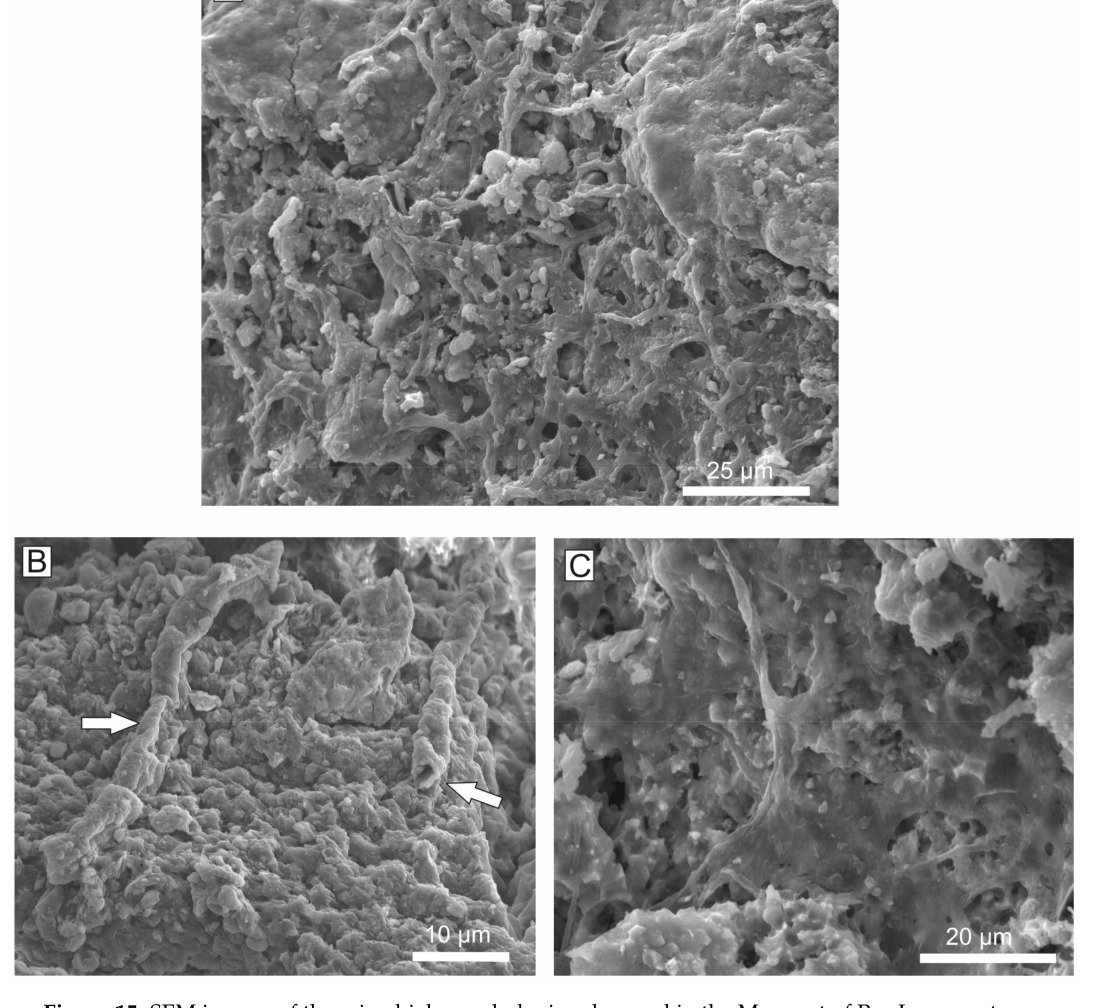
Figure 15. SEM images of the microbial morphologies observed in the Mn crust of Ras Leona outcrop. ( A ) Lamination formed by webs of branched filaments. ( B ) Rugose not-branched filaments with cellular cross walls. ( C ) Veil-like biofilm with some